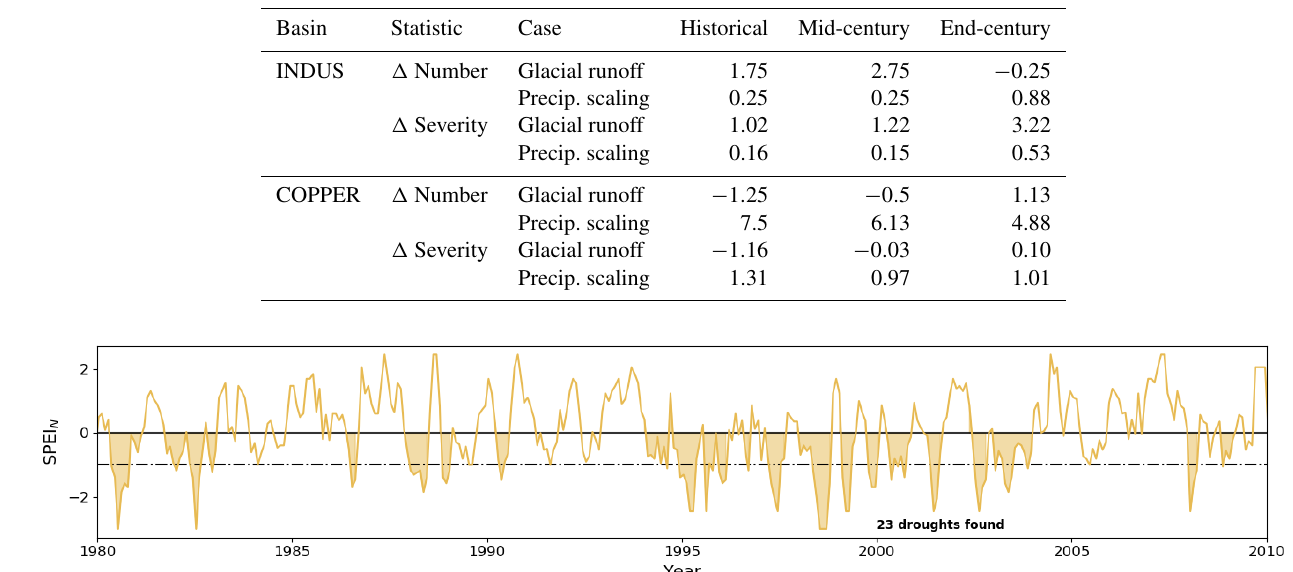
Table B1. Comparison of drought-buffering statistics computed with glacial runoff (SPEI N − SPEI G , as in main text Fig. 3) versus buffering from enhanced precipitation alone (SPEI N − SPEI PS , as described in Sect. B2.1). Statistics shown are multi-GCM means. Note that the Copper basin is heavily glaciated and has high precipitation; see Sect. B4 for a discussion of negative glacial buffering in such settings.